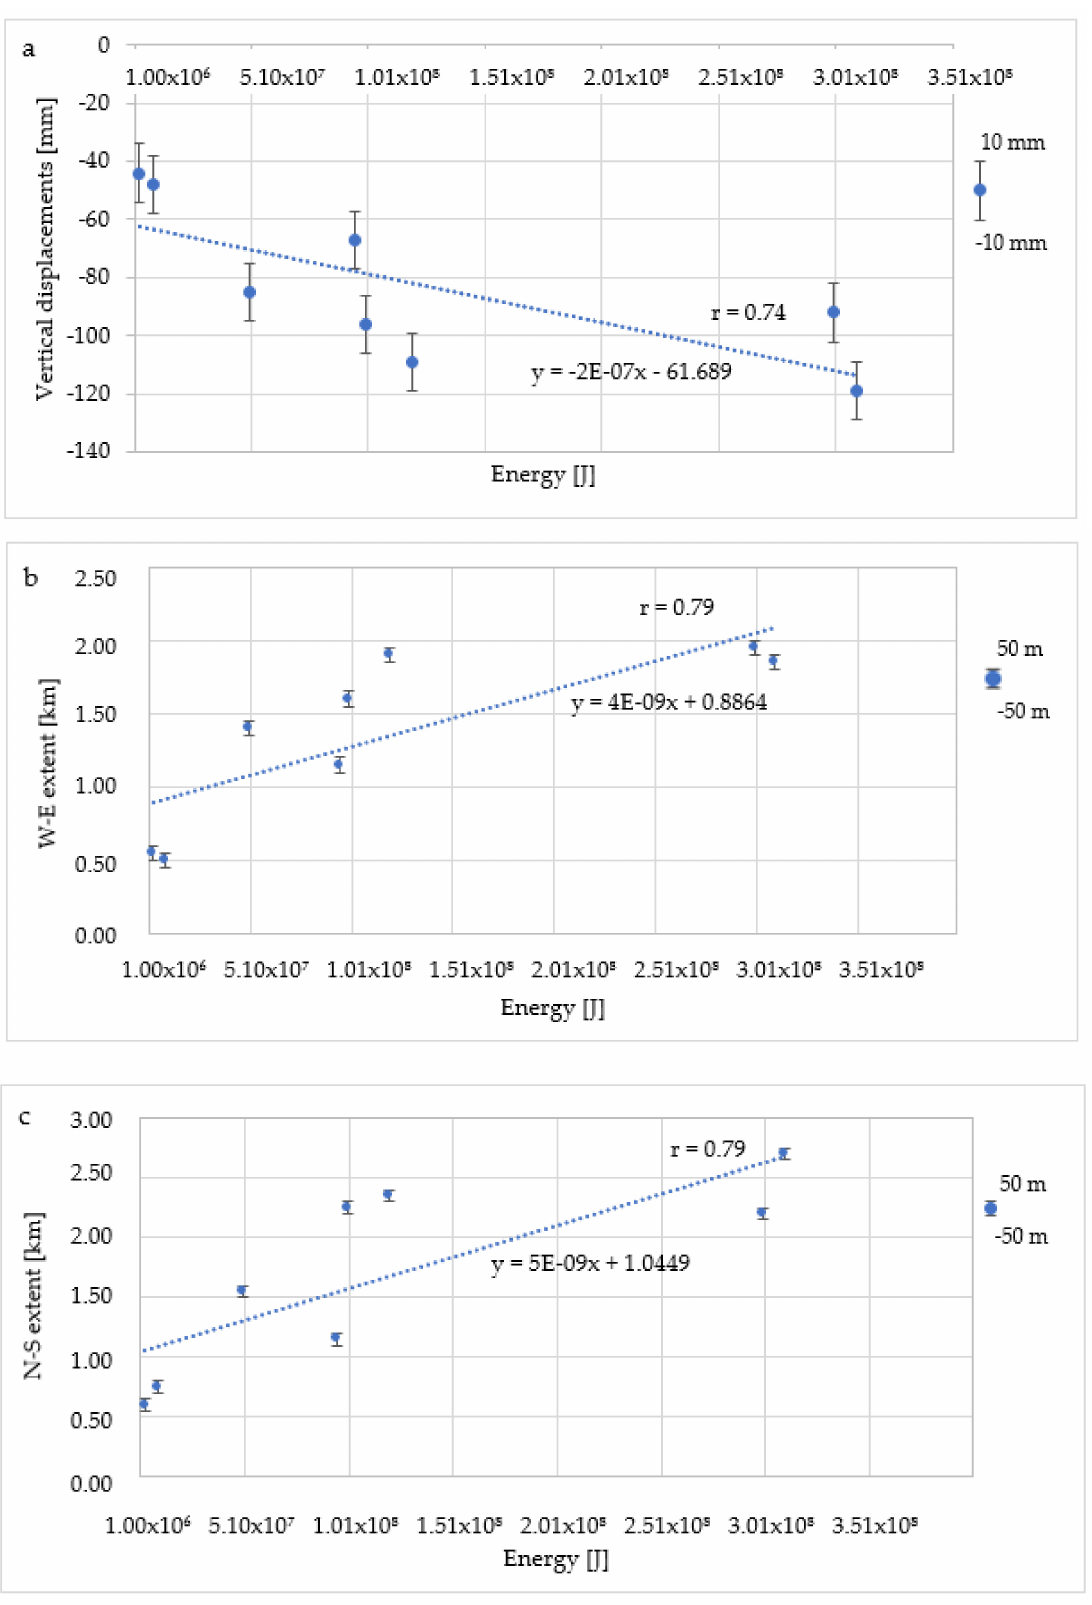
Figure 8. Graphs and Pearson coe ffi cient ( r ): ( a ) energy vs. max value of vertical displacements, ( b ) energy vs. mean value of W–E extent, ( c ) energy vs. mean value of N–S